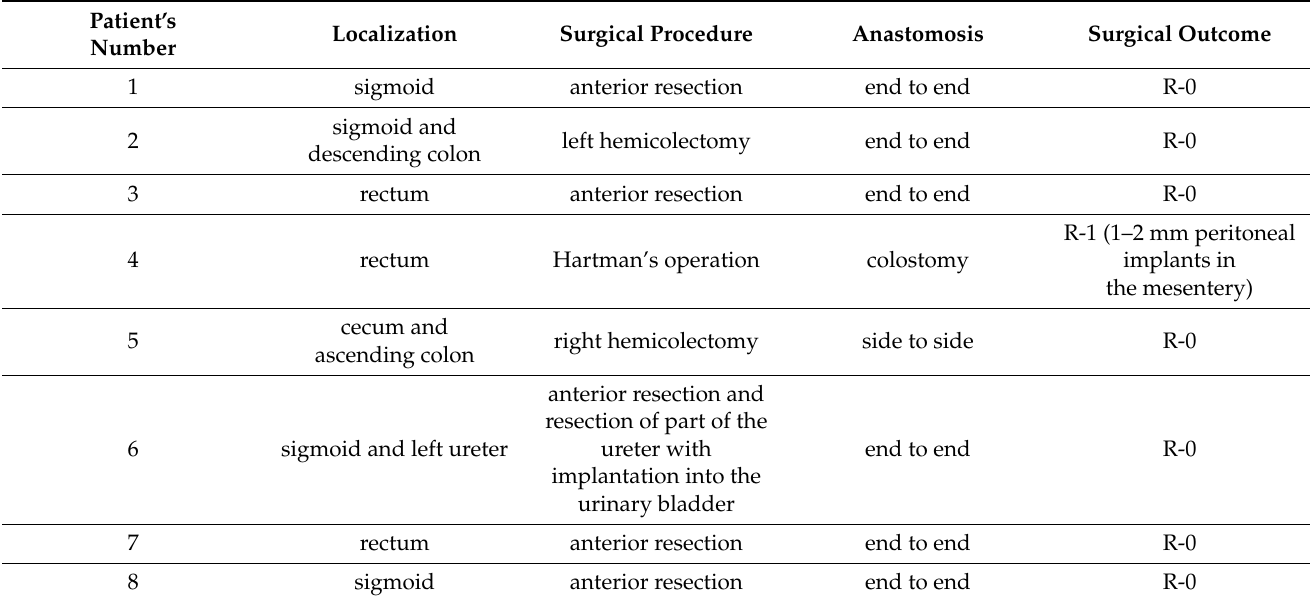
Table 4. The types and localization of the fistulas and the type and outcome of the surgical